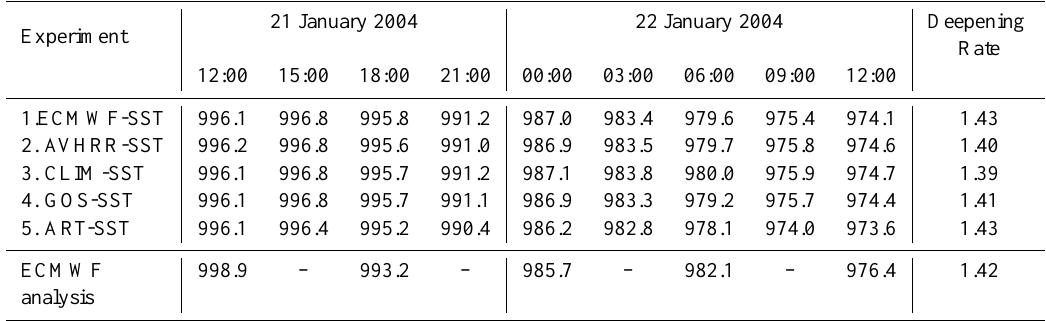
Table 2. The central mean sea level pressure (hPa) and the deepening rate (Bergeron) of the system in the five numerical simulations (ECMWF-SST, AVHRR-SST, CLIM-SST, GOS-SST and ART-SST) from 12:00 UTC on 21 January to 12:00 UTC on 22 January 2004. The last row of the table presents the central mean sea level pressure (hPa) and the deepening rate (Bergeron) of the system based on the ECMWF